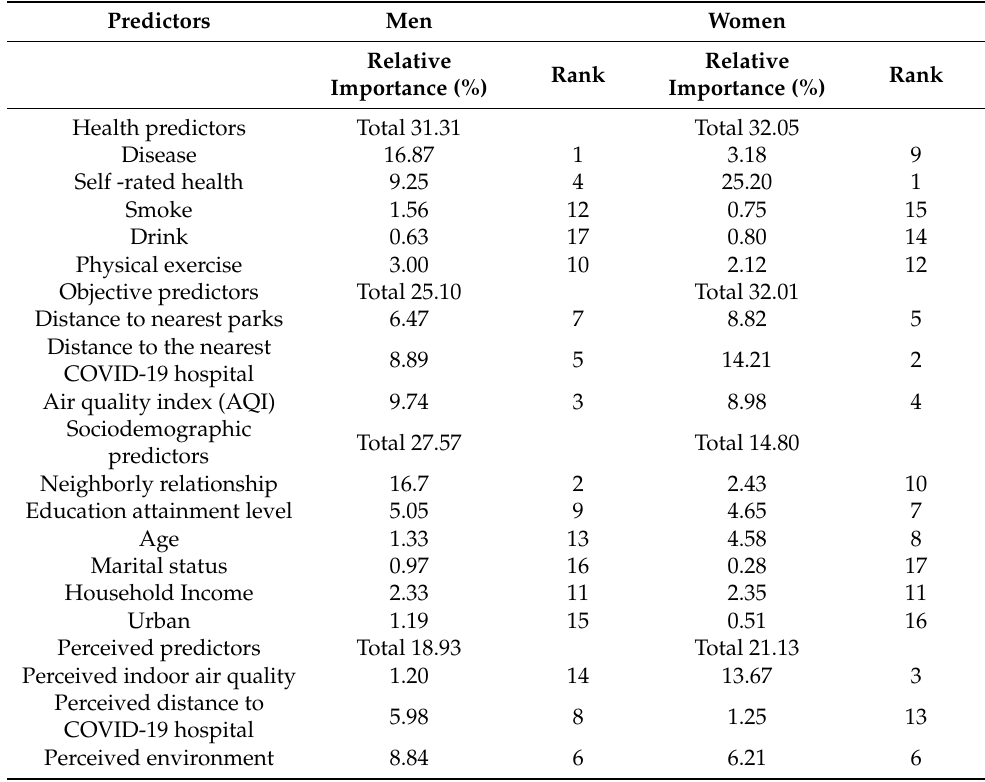
Table 3. Importance of independent variables in predicting psychological distress K6 score between men and